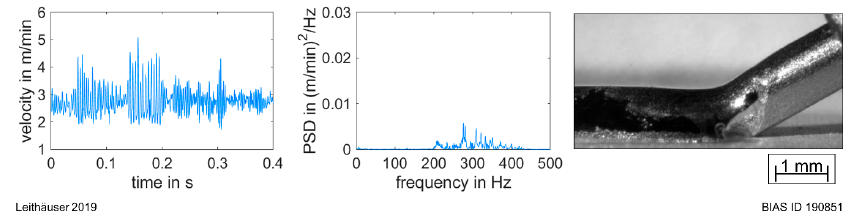
Figure 5. ( Left ) Wire velocity over time, when the wire hits the sheet and the retained force is released periodically. ( Middle ) Power spectral density (PSD) of the time signal. ( Right ) Snapshot of the high- speed recording during these events.